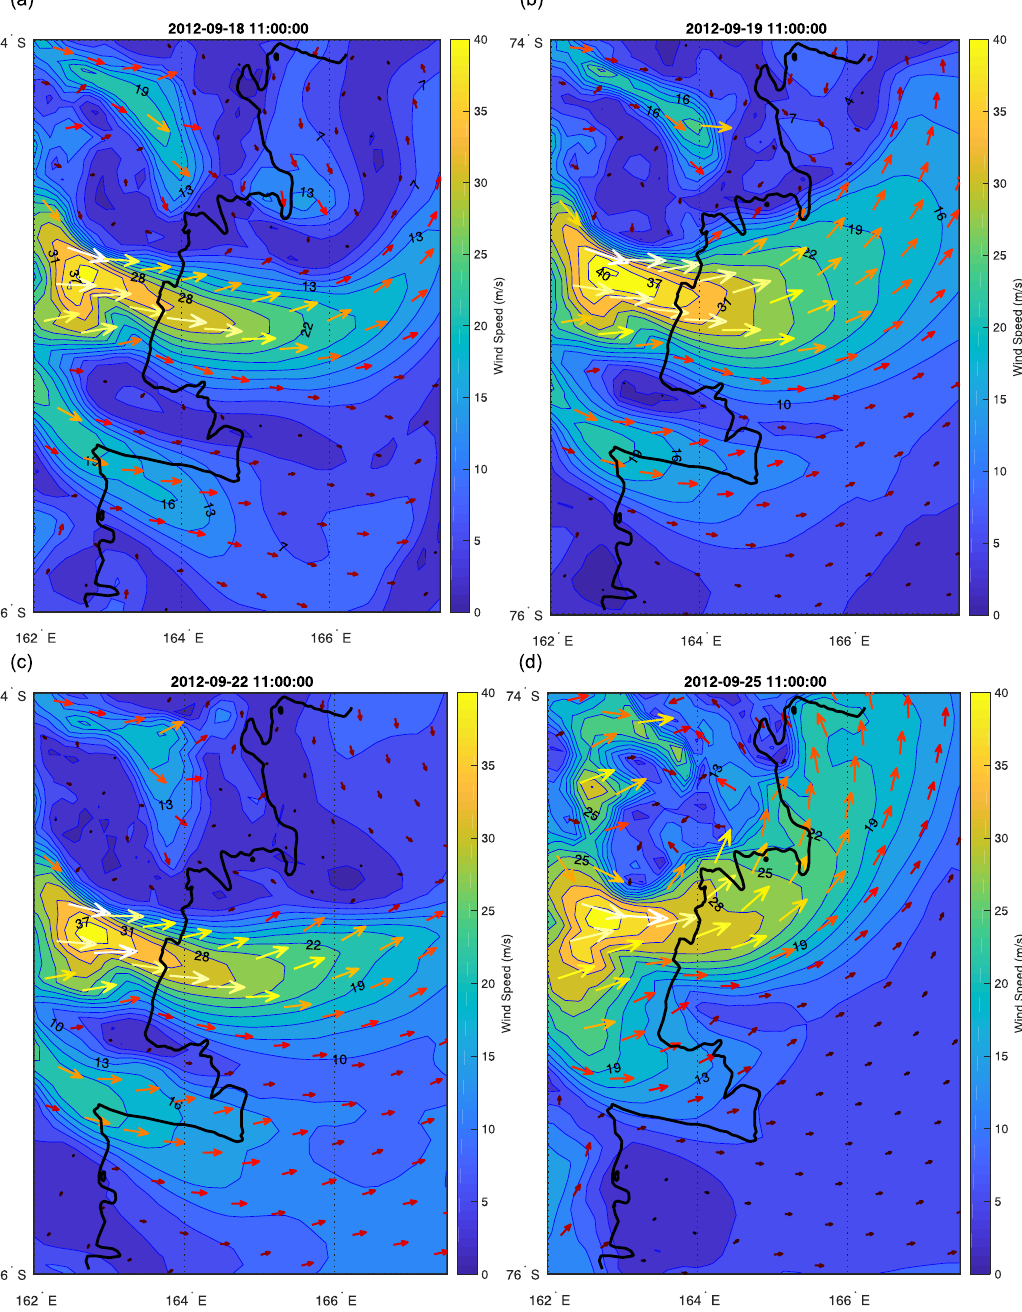
Figure 15. AMPS model wind speed results for Terra Nova Bay region for the days of UAS Aerosonde flights, ( a ) 18, ( b ) 19, ( c ) 22, ( d ) 25 September